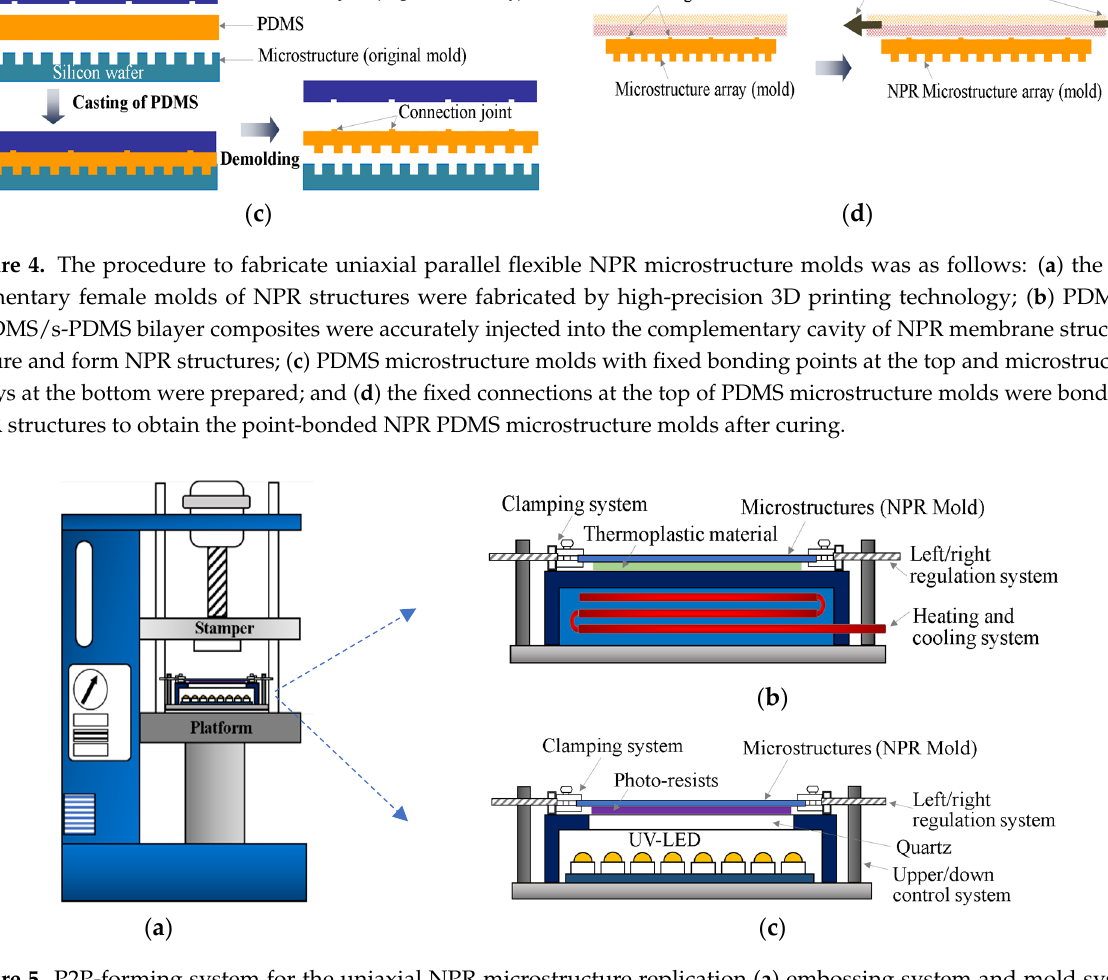
Figure 4. The procedure to fabricate uniaxial parallel flexible NPR microstructure molds was as follows: ( a ) the comple- mentary female molds of NPR structures were fabricated by high-precision 3D printing technology; ( b ) PDMS or h- PDMS/s-PDMS bilayer composites were accurately injected into the complementary cavity of NPR membrane structures to cure and form NPR structures; ( c ) PDMS microstructure molds with fixed bonding points at the top and microstructural arrays at the bottom were prepared; and ( d ) the fixed connections at the top of PDMS microstructure molds were bonded to NPR structures to obtain the point-bonded NPR PDMS microstructure molds after curing.